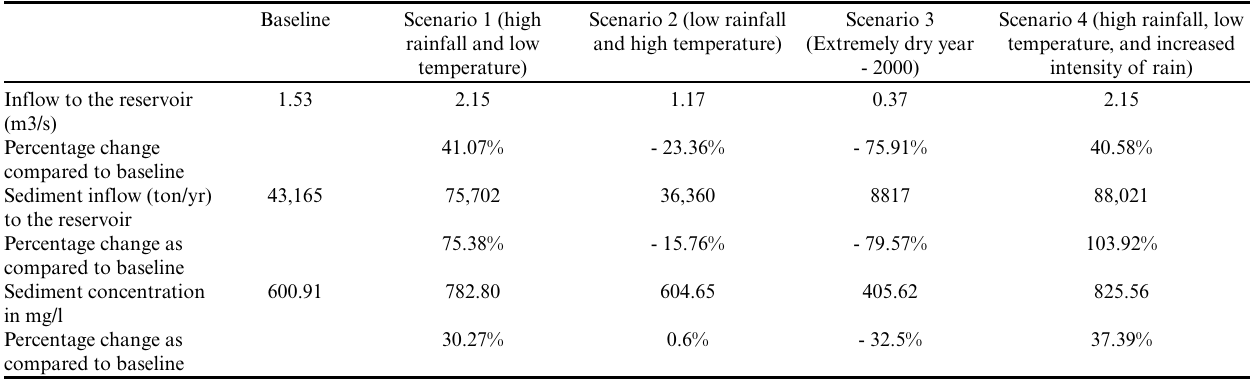
Table 5 . Water and sediment yield into Sasumua reservoir under baseline and different climate change